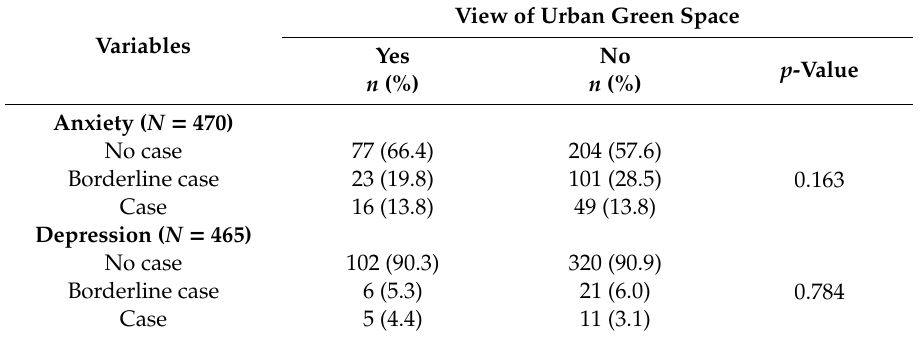
Table 2. Association of green spaces views from home with anxiety and depression in Carmona, Spain.